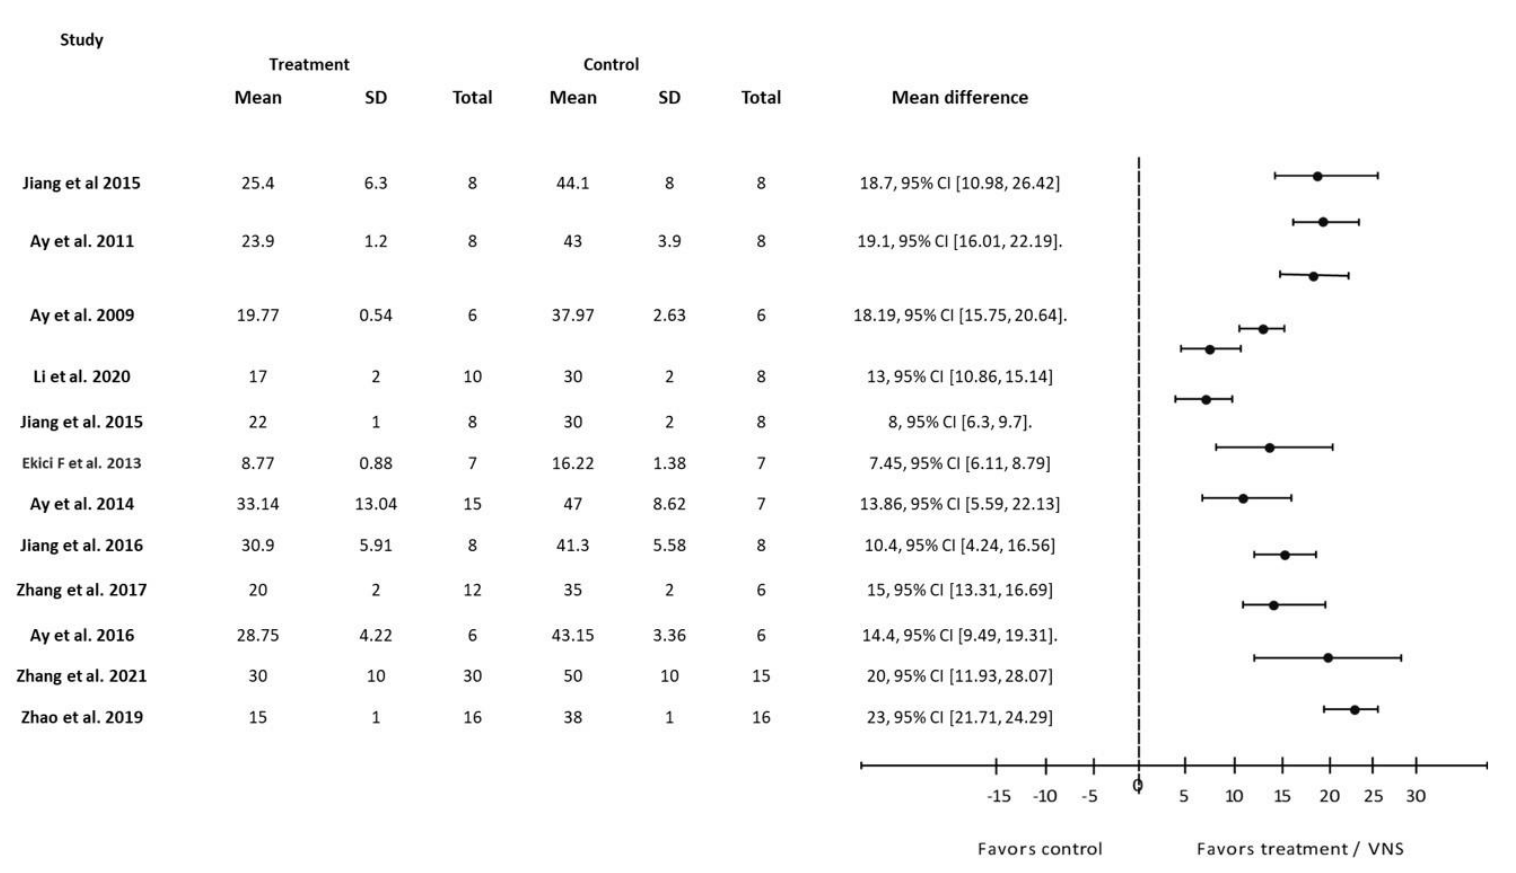
Figure 3. Forest plot: the outcome of vagus nerve stimulation (VNS) on infarct size reported as percentage reduction (%). The effect of each study (“favors control”, “favors treatment”, or “no effect”) was estimated through the standardized mean difference (horizontal axis). The dashed vertical line at 0 indicates that the study was determined to have “no effect”. The horizontal bars in each chart plot represent the mean difference with a 95% confidence interval for each study [22,23,26,32,34,35,37 – 39,41,42,49].